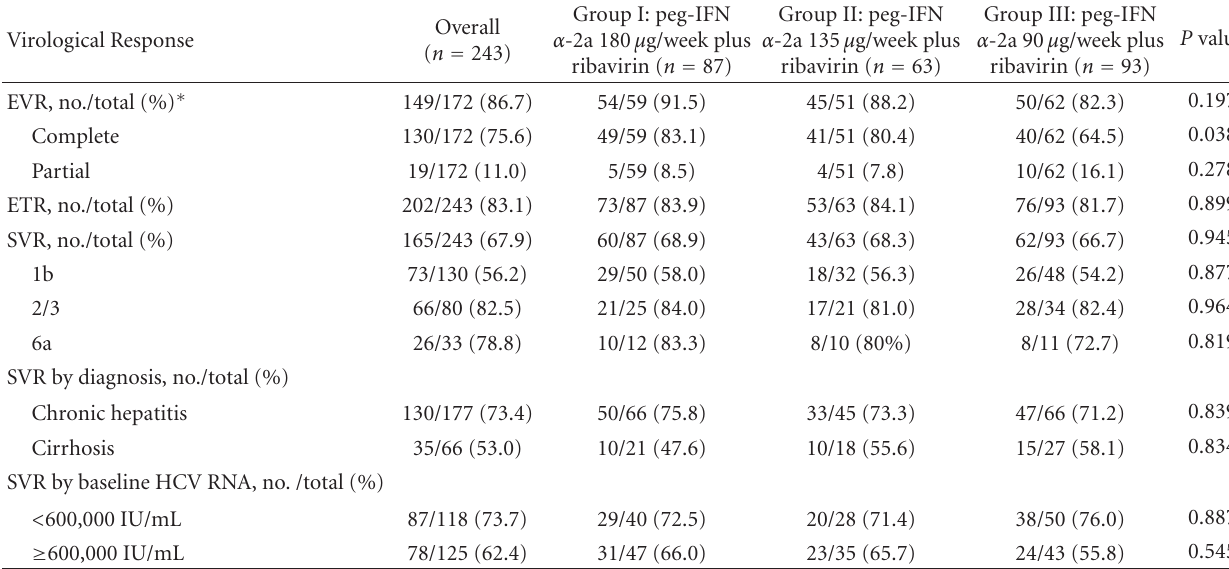
Table 2: Virological response during treatment and at the end of